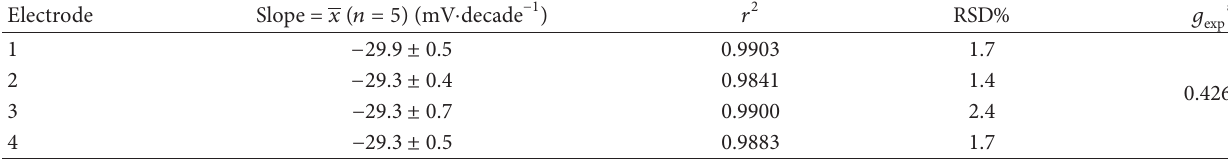
T 8: Potentiometric response of four independent optimized SMZ-PVC membrane electrodes. Electrode